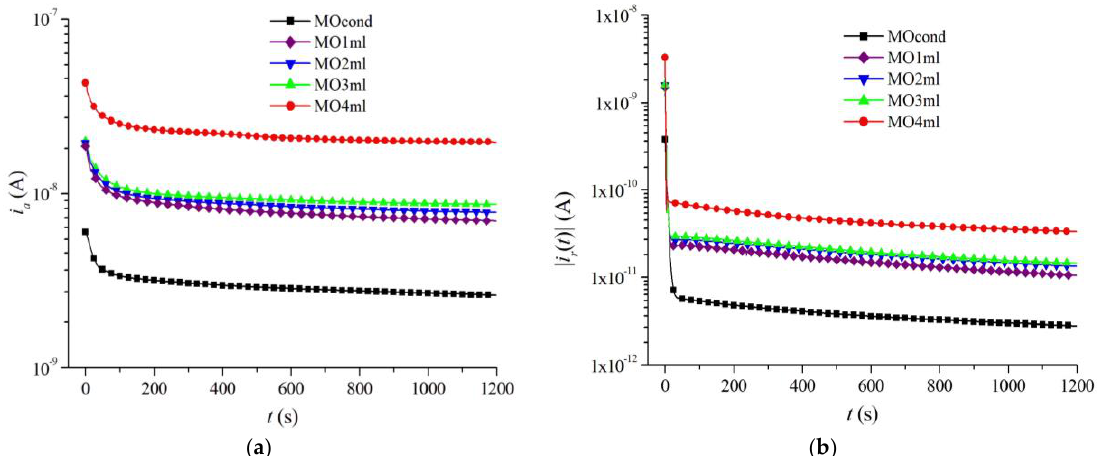
Figure 7. ( a ) The variation of the absorption current against time; ( b ) variation of the modulus of the resorption current against ( U 0 = 200 V and T = 24 °C).